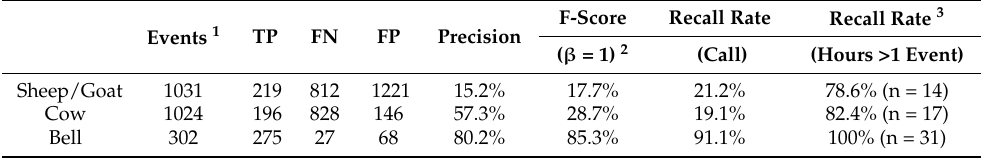
Table 4. Evaluation metrics of the sheep bleat, cow lowing, and livestock bell detection algorithms against events located manually (“truth” dataset) in data from multiple days and sensors (TP = true positive detections; FN = false negative detections; FP = false positive detections).